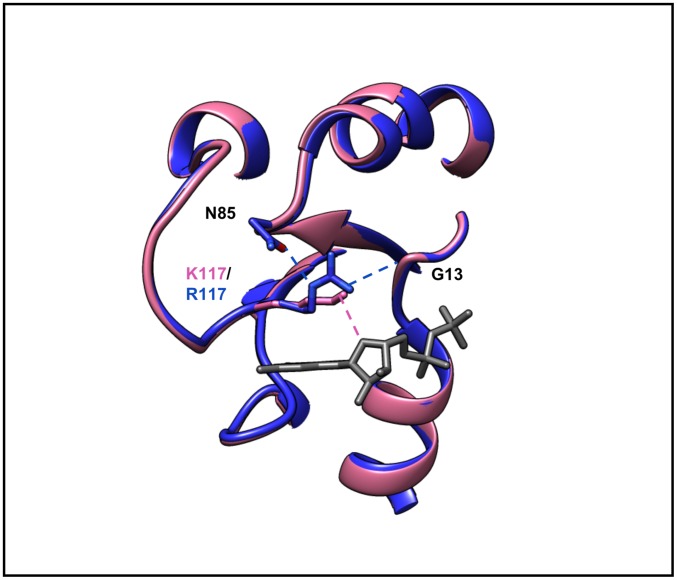
Close-up view of the nucleotide-binding region of Lys117Arg.The mutated residue R117 is stabilized by interactions with the P-loop (Gly13, main-chain CO) and additional interaction with Asn85. Thus the mutated residue causes destabilization of nucleotide binding owing to loss of a direct contact with the ligand. Mutated PDB: 2QUZ(blue) and wild-type PDB: 2CE2 (pink).